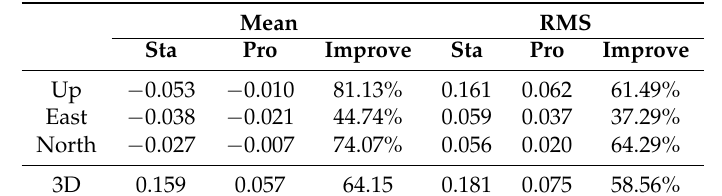
Table 5. Statistics of the mean and RMS residuals for standard approach and proposed method during Event 2. The unit is m .